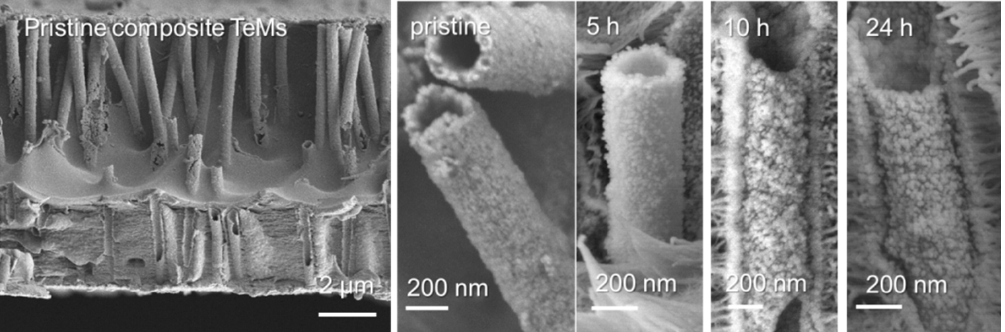
Figure 5. SEM images of composite membrane and individual copper microtubules attained at different annealing times.